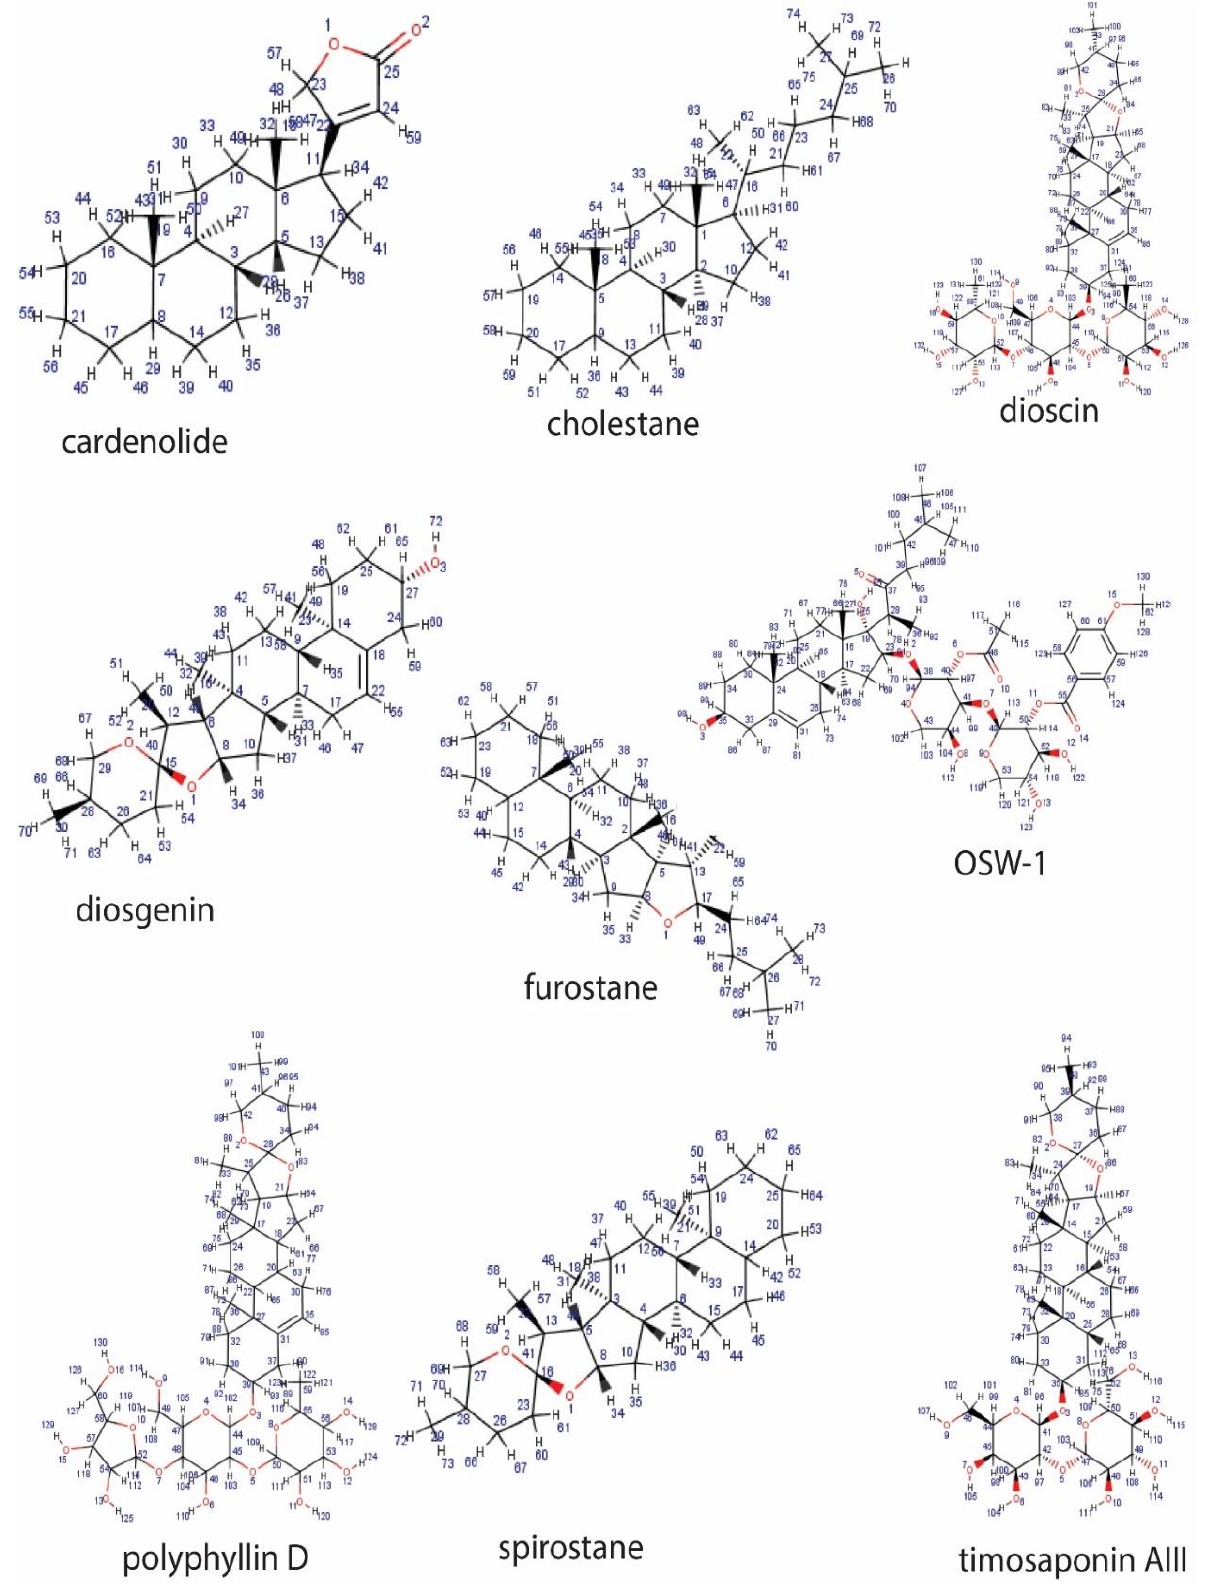
Figure 2. Representative sapogenin structure of steroid saponins.